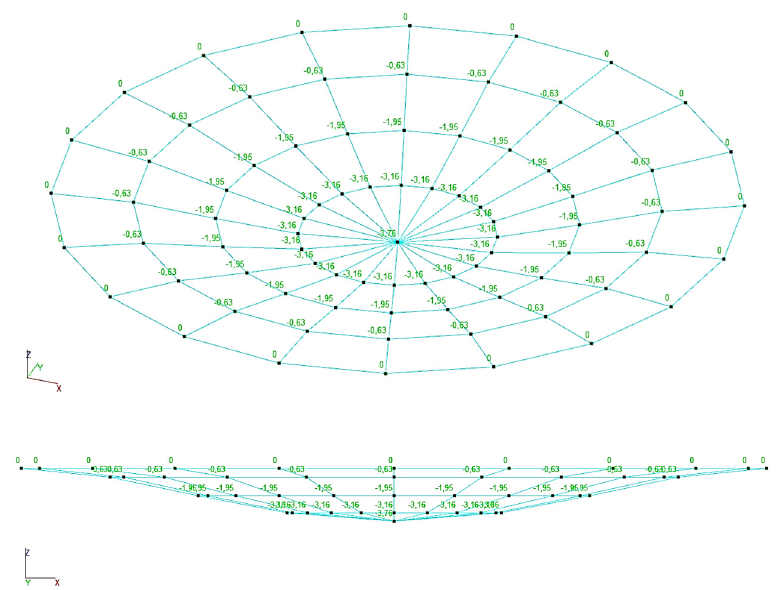
Figure 10. Graphical analysis of displacements in membranes.